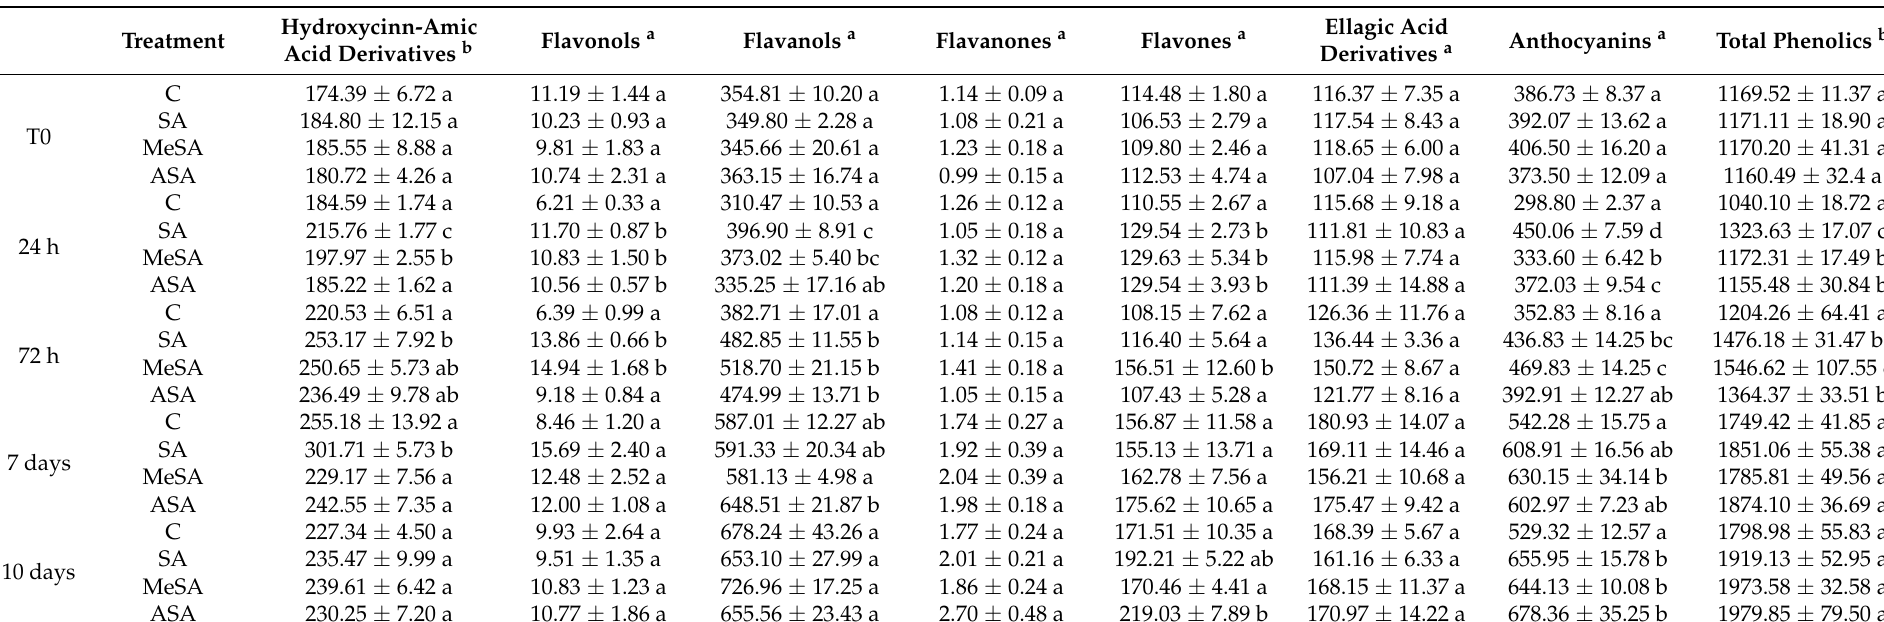
Table 4. Content of Total Identified Phenolic Groups (mg/kg FW) in Salicylic Acid (SA), Methyl Salicylic Acid (MeSA) and Acetyl Salicylic Acid (ASA) Treated Strawberries at Different Time Points (T0, 24 h, 72 h, 7 days and 10 days after treatments with salicylates) a